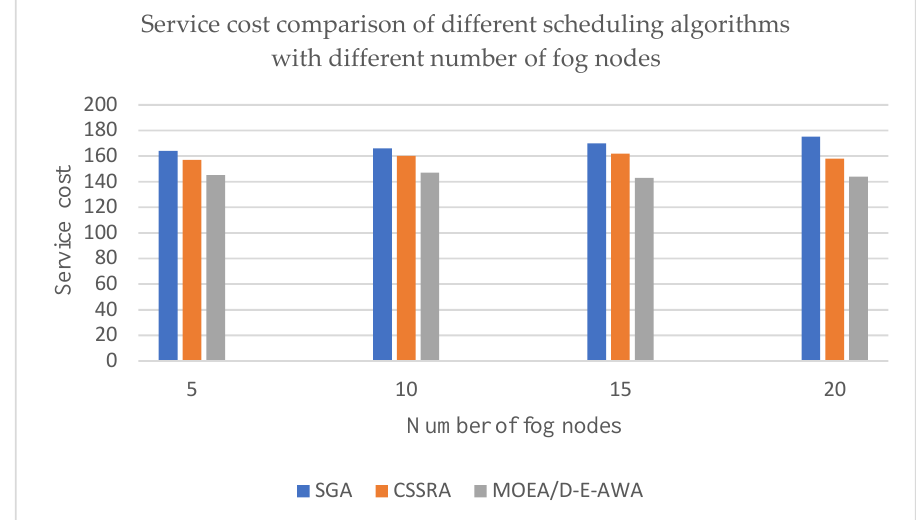
Figure 8. Comparison of Service Cost.